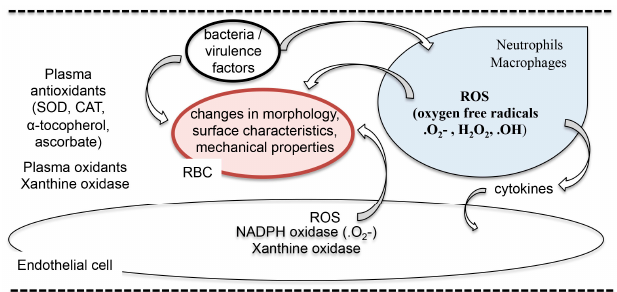
Figure 2. Interactions between erythrocytes, bacterial virulence factors, phagocytes and endothelial cells and sources of red blood cell (RBC) exposure to reactive oxygen species (ROS). The schematic depicts interactions between bacteria and virulence factors with erythrocytes and phagocytes. Phagocytes generate oxygen free radicals, release reactive oxygen species and activate endothelial cells (EC) that also release ROS, exposing RBCs to exogenous sources of ROS. The plasma contains oxidant generating enzymes and various antioxidants that act to scavenge ROS. In addition to exposure from exogenous ROS, the RBC is also exposed to endogenous sources of ROS via hemoglobin autoxidation. Abbreviations: SOD (superoxide dismutase), CAT (catalase), .O 2 − (superoxide anion), H 2 O 2